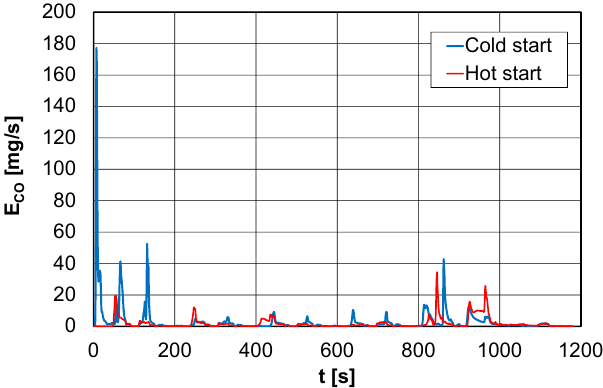
Figure 3. Carbon monoxide exhaust emissions (E CO ) for cold and hot engine start. In the case of the hydrocarbon emission (Figure 4), the influence of the engine thermal state was very strongly visible. After starting the engine, the hydrocarbon emission rate was much higher for the engine cold start, while for a warm engine, the hydrocarbon exhaust emission significantly increased in the EUDC test when the engine was under a heavier load than in the UDC test.